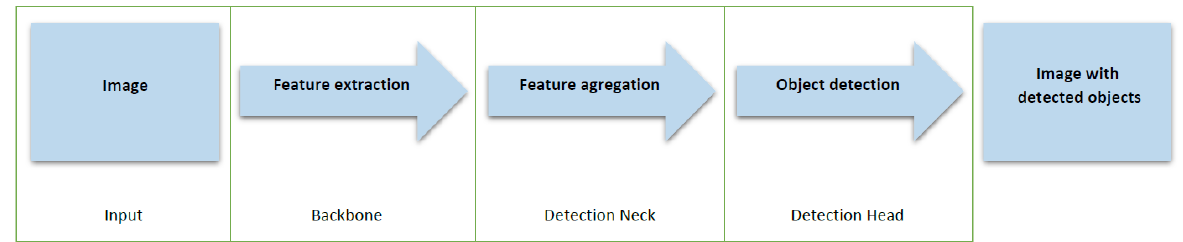
Figure 2. Object detector is composed of input, backbone, neck, and head parts.